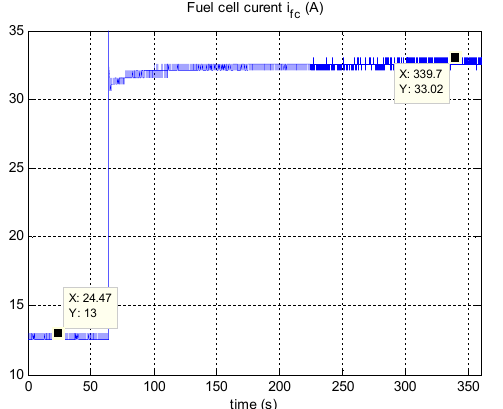
Figure 9. Fuel cell current step change.